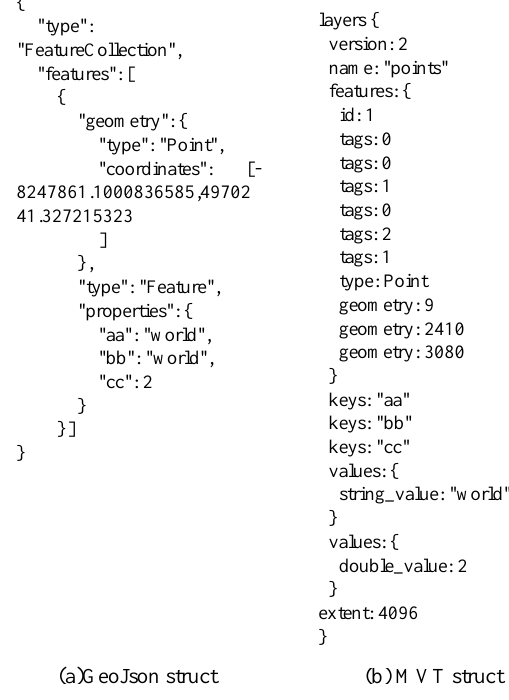
where i represents the level of the pyramid model.